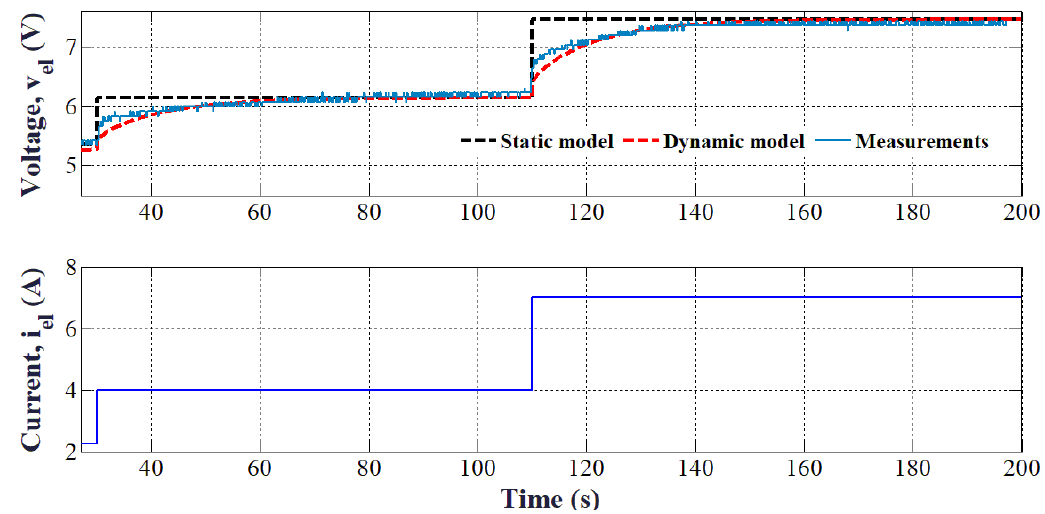
Figure 20. Comparison of the voltage response between a static and a dynamic model [24].